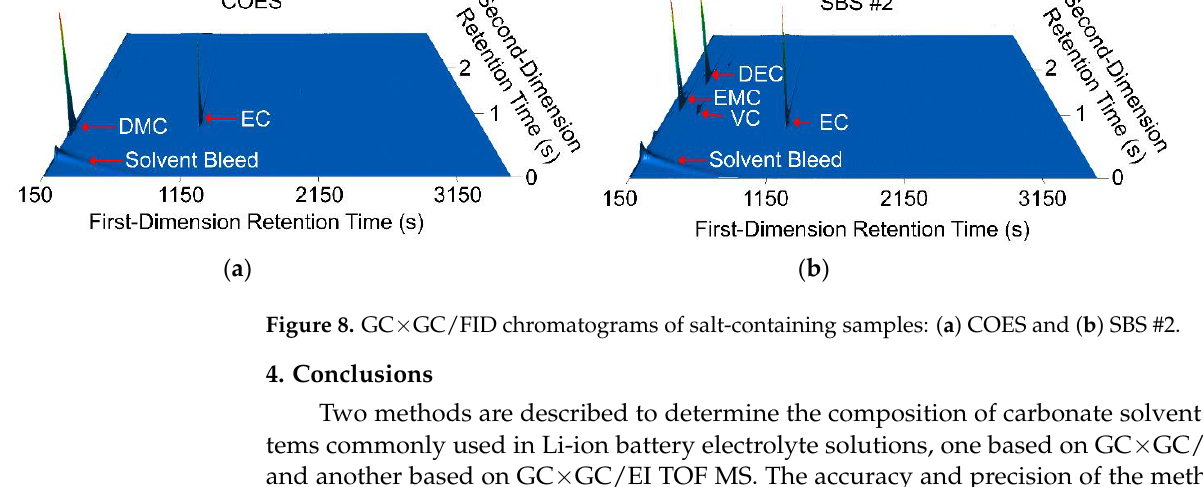
Figure 7. GC×GC/FID chromatograms of acetone before ( a ) and after ( b ) ten samples containing LiPF 6 were analyzed.